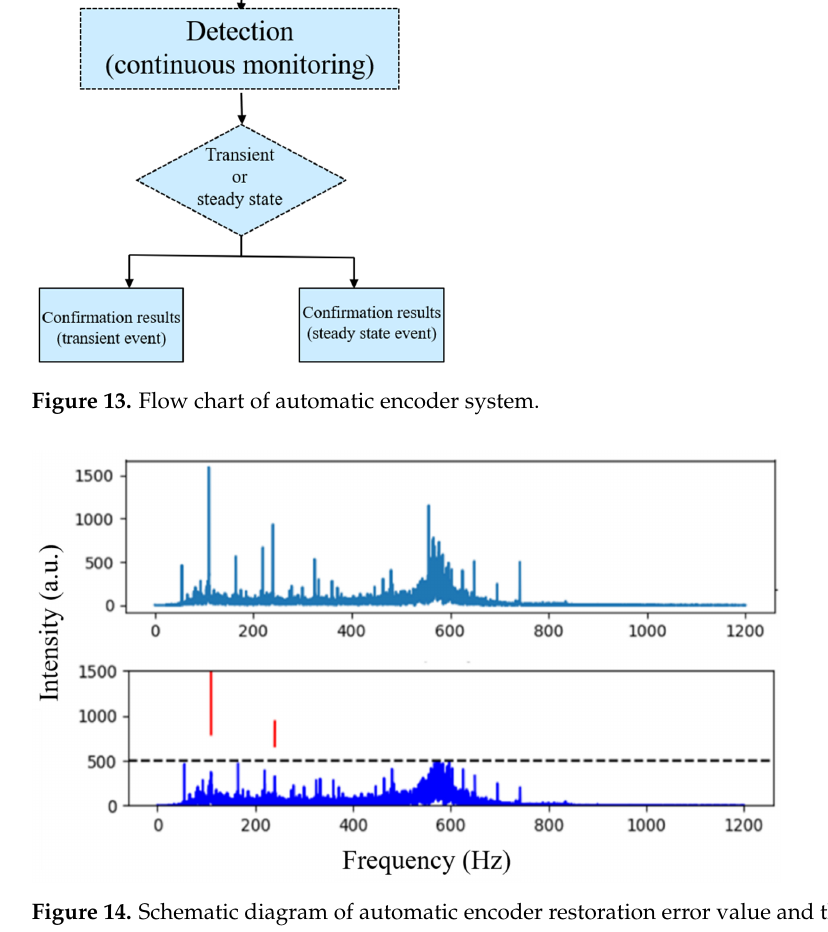
Figure 14. Schematic diagram of automatic encoder restoration error value and threshold value.